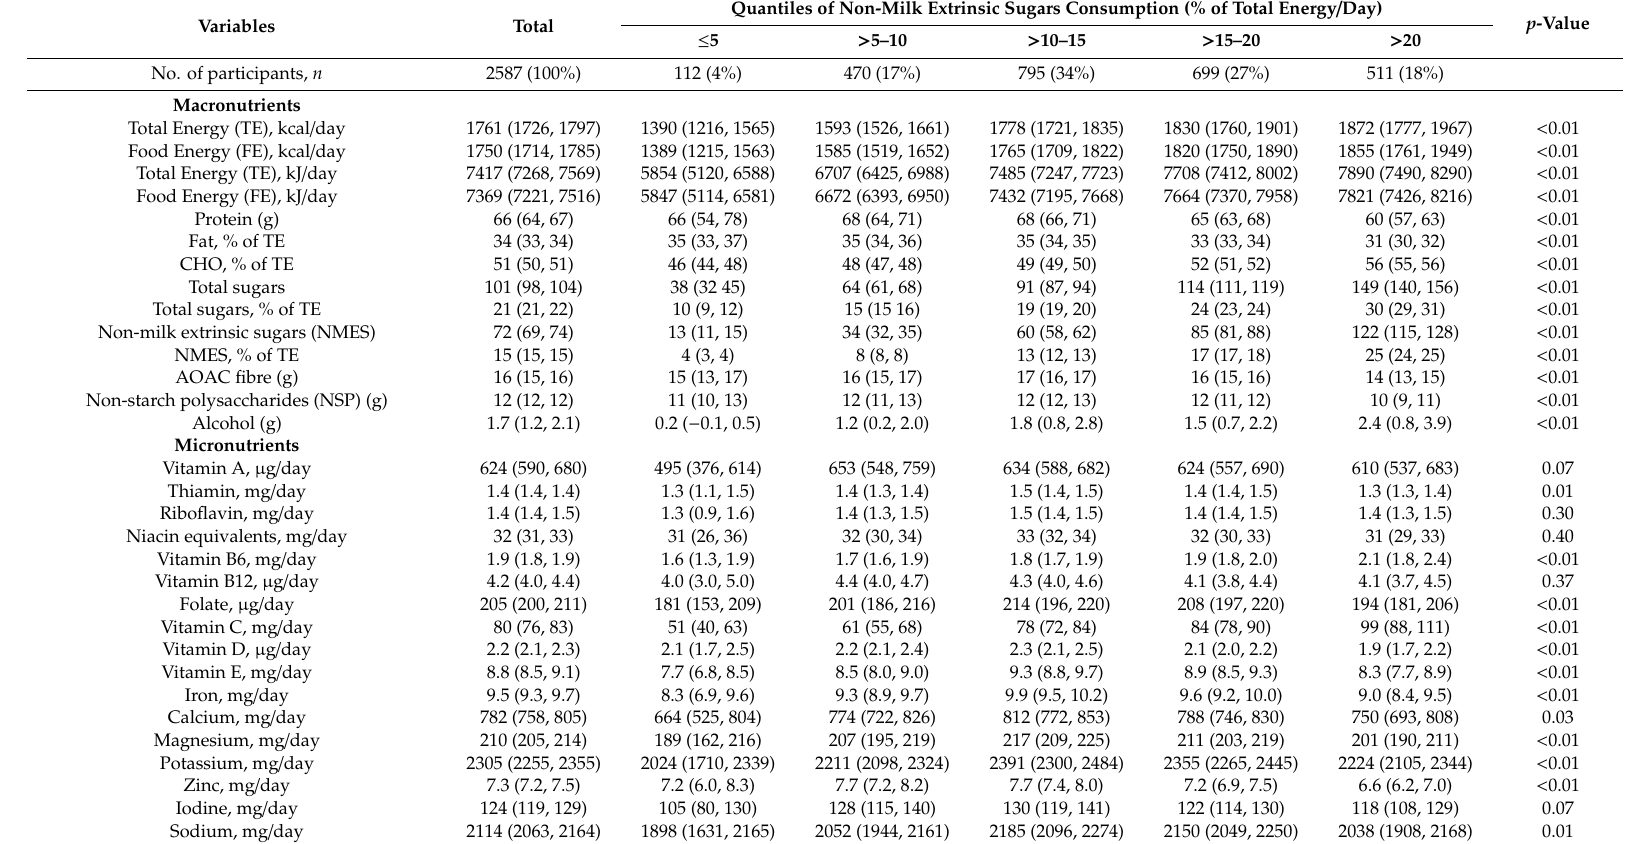
Table 3. Daily mean (99% CI) nutrient intakes of adolescents aged 11 to 18 years in the National Diet and Nutrition Survey Y1-8 by percentage of non-milk extrinsic sugars consumption of total energy ( n = 2587) after the application of survey